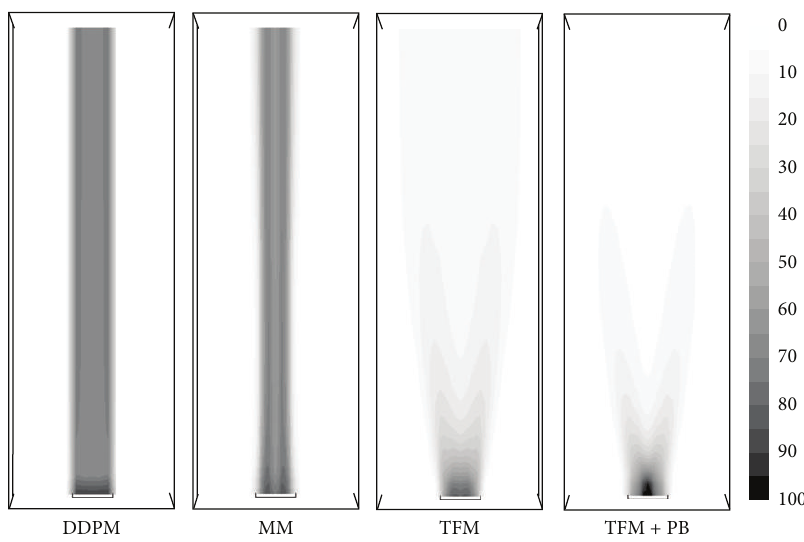
Figure 4: Contours of the scattering coefficient (in m −1 ) predicted by the different models along an axial midplane in the